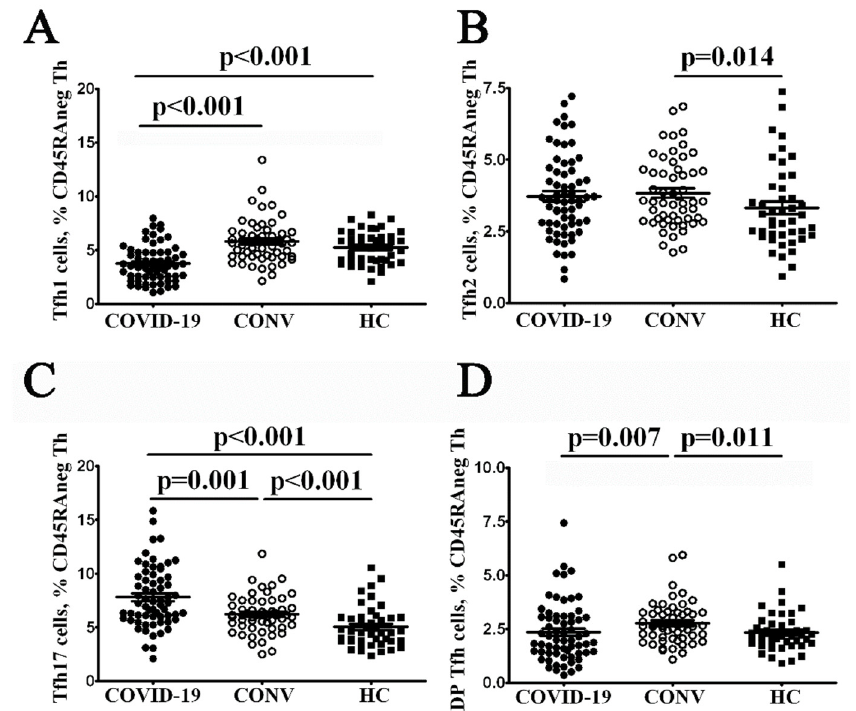
Figure 2. Imbalanced Tfh cell subsets in patients with acute COVID-19 and COVID-19 convalescent patients. From left to right: scatter plots showing the percentages of CXCR3+CCR6 − Tfh1-like ( A ), CXCR3 − CCR6 − Tfh2-like ( B ), CXCR3 − CCR6+ Tfh17-like ( C ) and unclassified double-positive CXCR3+CCR6+ T cell subsets among total CD3+CD4+CD45RA − T cell population ( D ), respectively, in the peripheral blood samples from patients with acute COVID-19 (COVID-19, black circles, n = 64), COVID-19 convalescent patients (CONV, white circles, n = 55) and healthy control (HC, black square, n = 44). Each dot represents individual subjects. and horizontal bars depict the group mean and standard error of the mean (Mean ± SEM). Statistical analysis was performed with the Mann-Whitney U test.